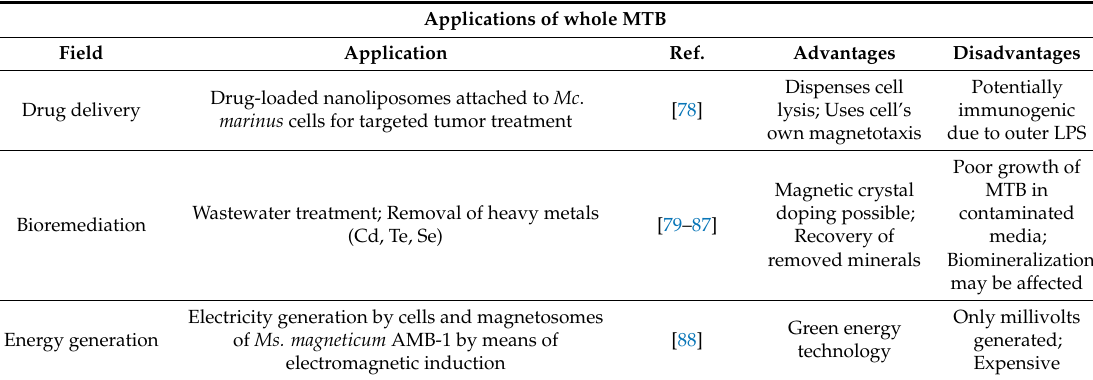
Table 1. Summary of biotechnological applications of whole magnetotactic bacteria (MTB) cells and magnetosomes comparing advantages and limitations of each